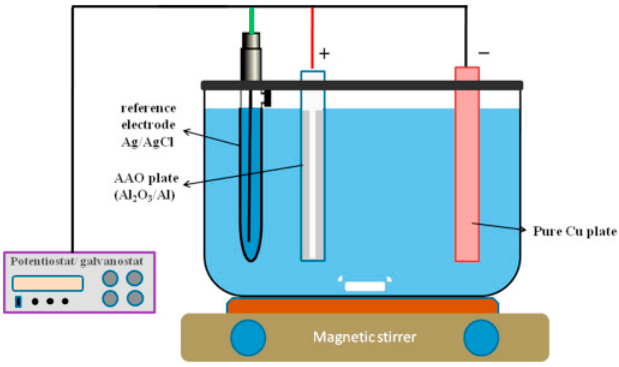
Figure 5. Schematic setup for electrodeposition of copper metal particles over aluminum oxide [52].